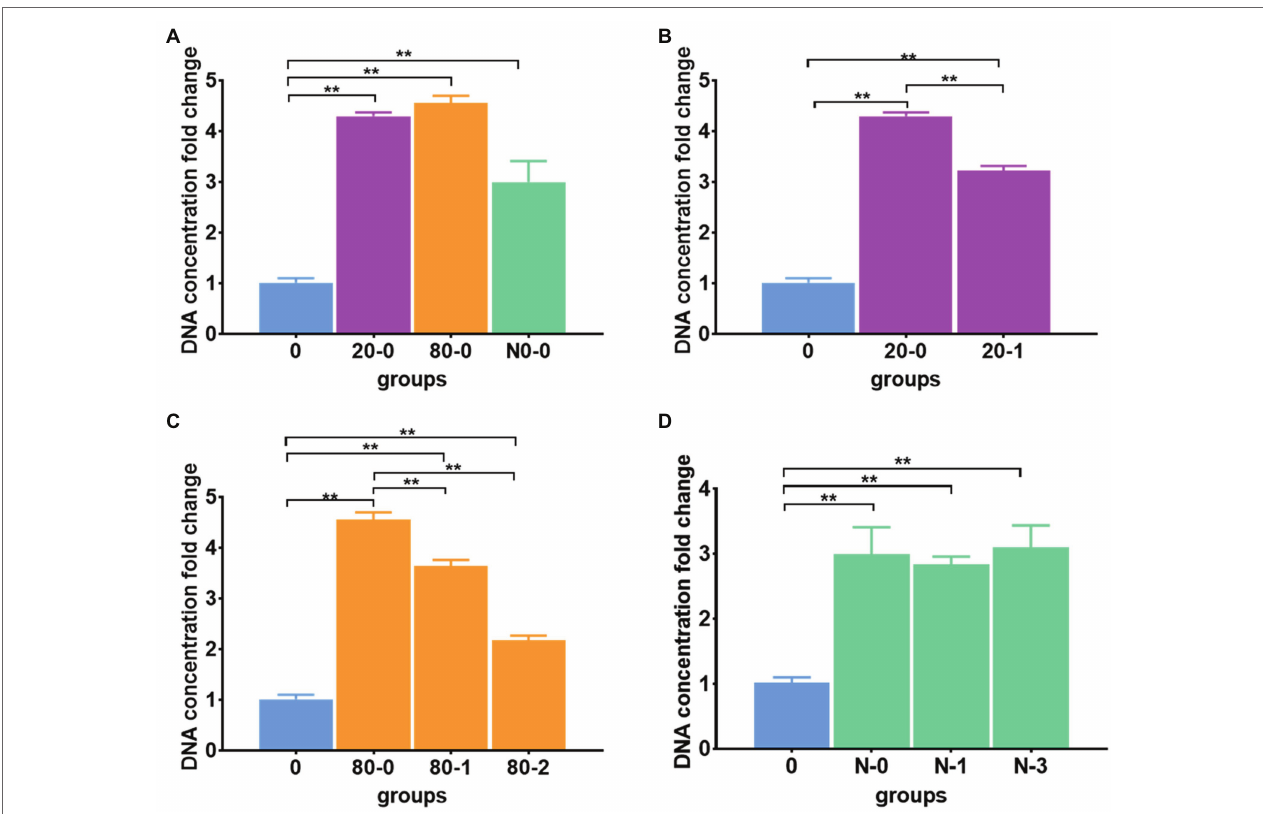
FIGURE 2 | Different thawing protocols affected DNA extraction efficiency. (A) The DNA extraction efficiencies for immediately thawed meconium frozen at − 20 and − 80 ° C and in liquid nitrogen; (B) The DNA extraction efficiencies for immediately thawed and gradient thawed meconium frozen at − 20 ° C; (C) The DNA extraction efficiencies for immediately thawed and gradient thawed meconium frozen at − 80 ° C; (D) The DNA extraction efficiencies for immediately thawed and gradient thawed meconium frozen in liquid nitrogen. The corresponding data were shown in Supplementary Table S3 . ** P <